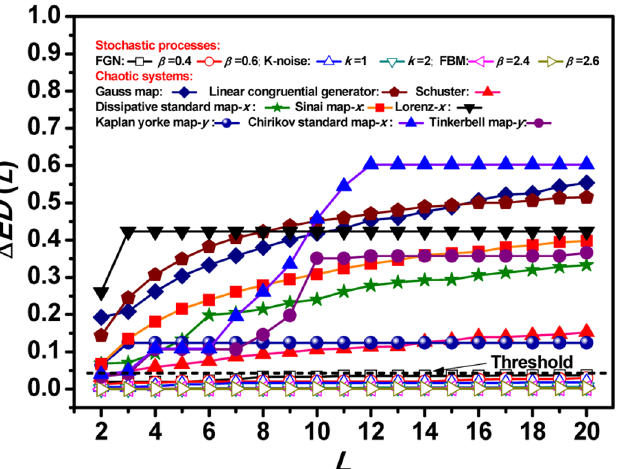
Fig 3. The results of Δ ED ( L ) for different SPs and CSs. It is almost unchanged near zero for SPs, but changing a lot for CSs. The distinction between CSs and SPs is significant when the scale range is larger than 4. A threshold of 0.039 (dash line) chosen as the maximum of Δ ED ( L ) from 1000 SPs is shown in the